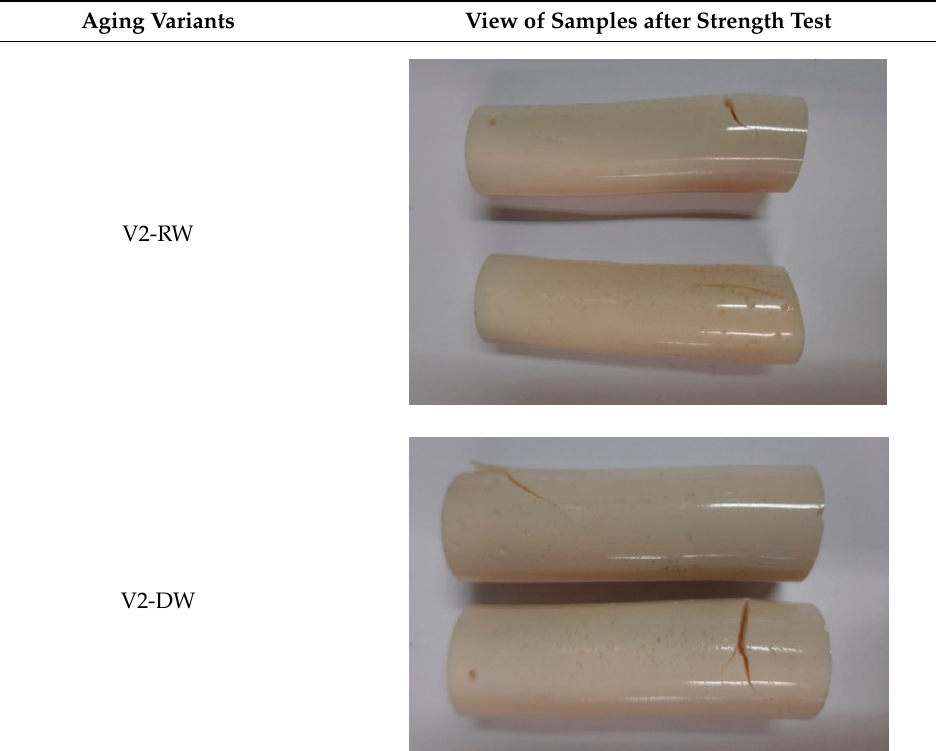
Table 6. View of the shape of the Epidian 57/Z-1/10:1 epoxy compounds sample—variant II.